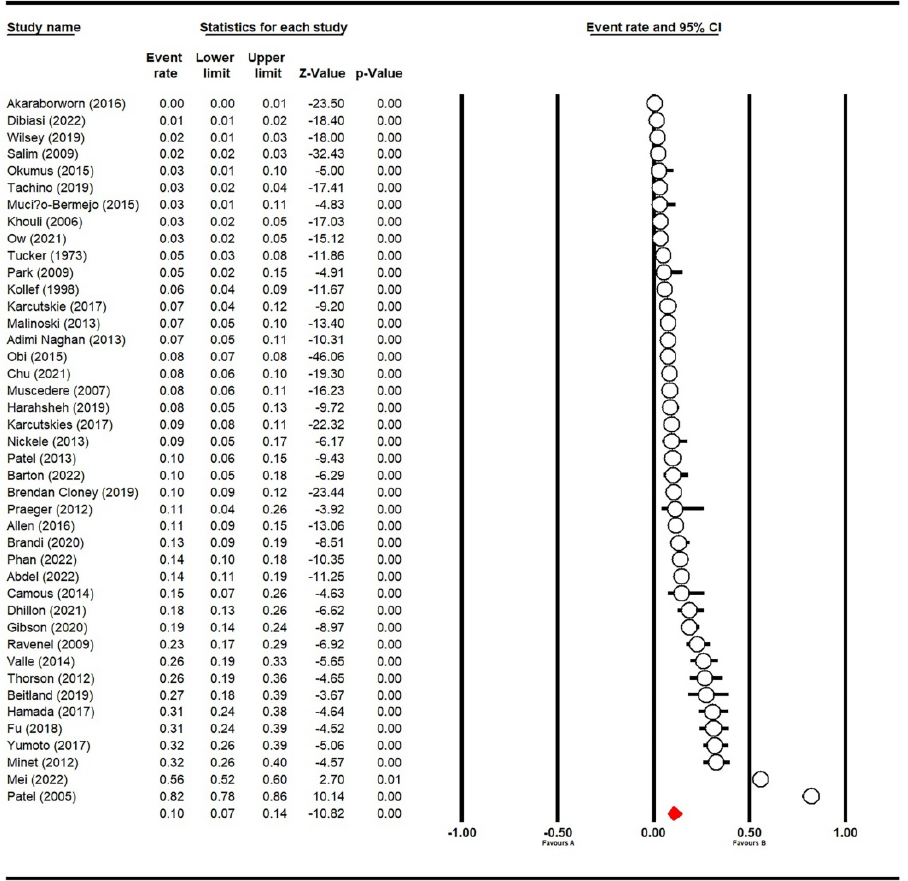
Figure 2. Forest plot of prevalence of VTE in ICU patients ( n = 42) [5,6,25–64]. The red symbol indicated the prevalence of VTE in ICU patients.